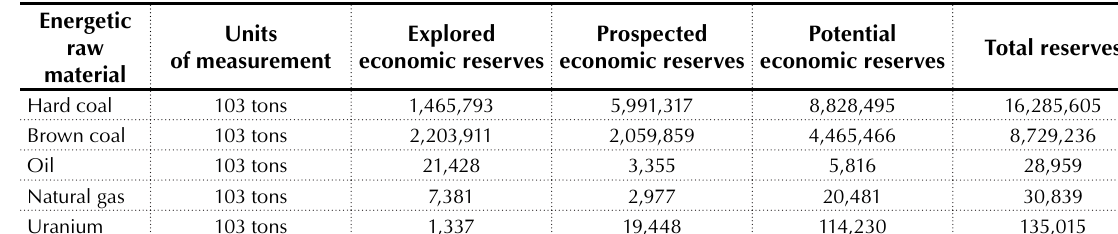
Source: Česká geologická služba